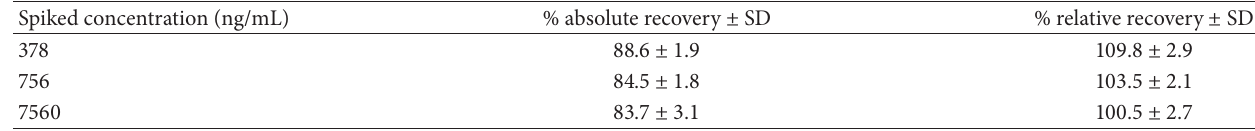
Table 1: The absolute and relative recovery of muscone from rat serum ∗ .